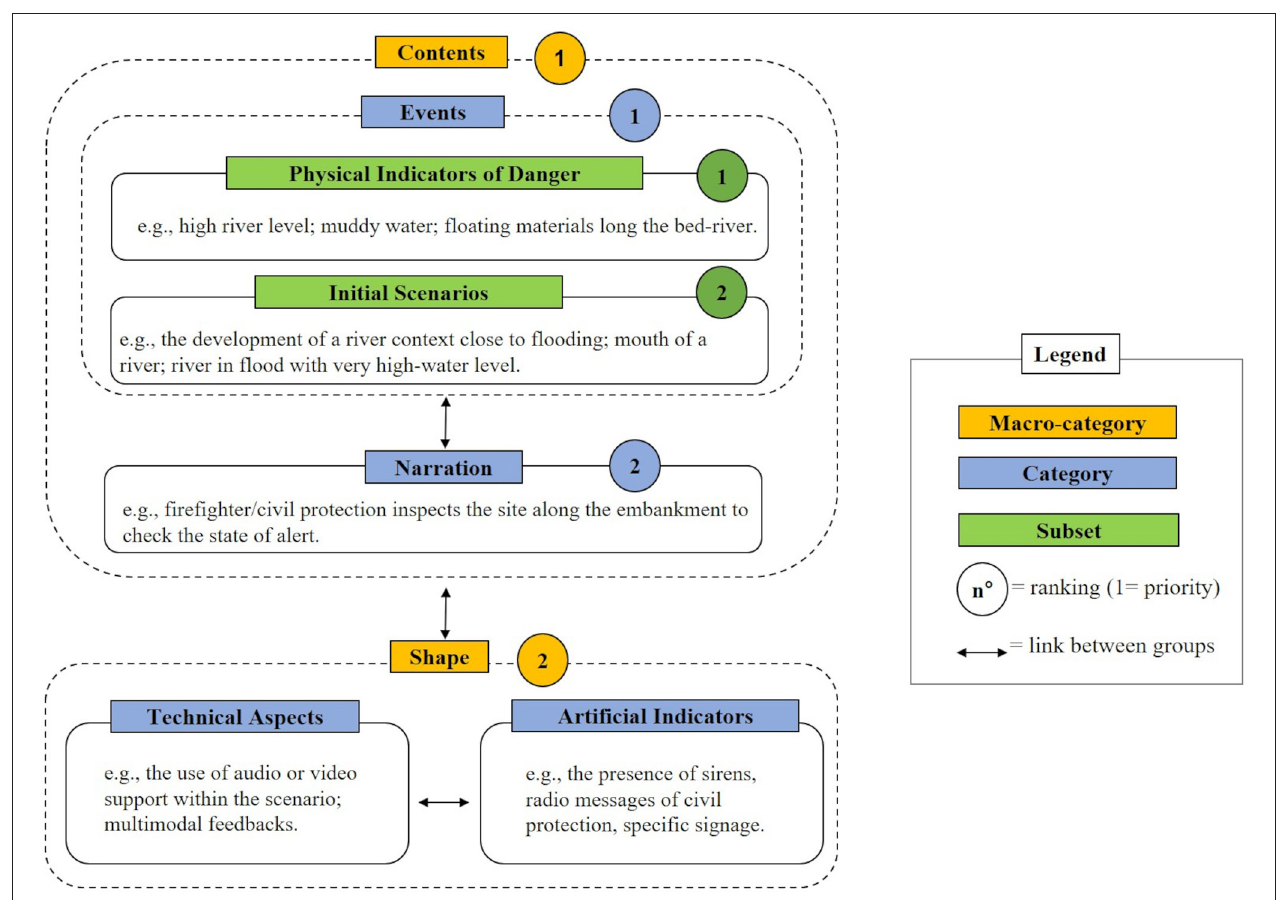
FIGURE 2 | Schematic representation of the results of the first affinity diagram